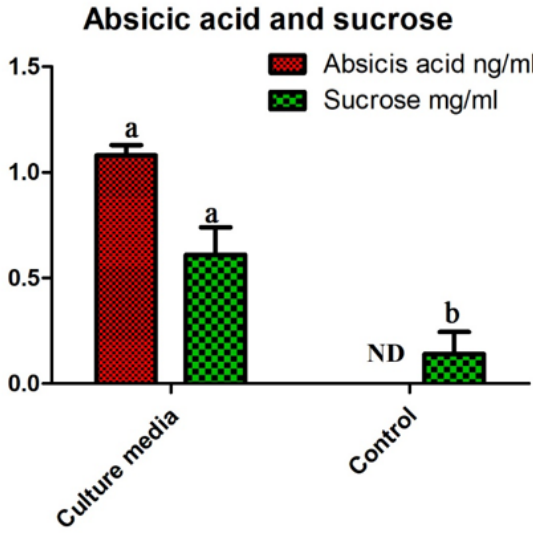
Figure 4. ABA and sucrose quantification in isolate SH-6 cultured in LB broth media. Each data point is the mean of 5 replicates. The latter on each bar is the significant different between treatment at p ≤ 0.5, where ND = not detected. The error bar represents the standard error among the replicates.